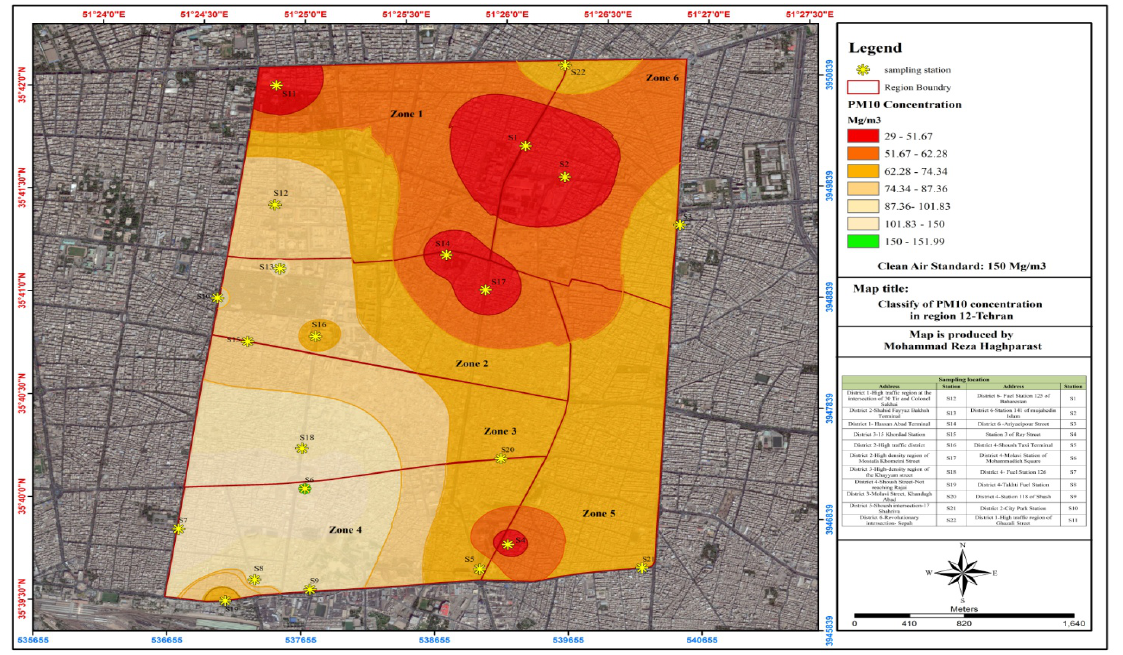
Figure 6. Zoning PM concentration in the region on January, 2018 10 The concentration of PM The highest concentrations were observed at the eastern end of 2.5 the boundary of the zone 3 and 4. This pollutant throughout the district 12 was higher than the standard limit and it was lower than the 24-hour standard limit specified in the clean air standard in some areas of the zones 1, 6 and 2.